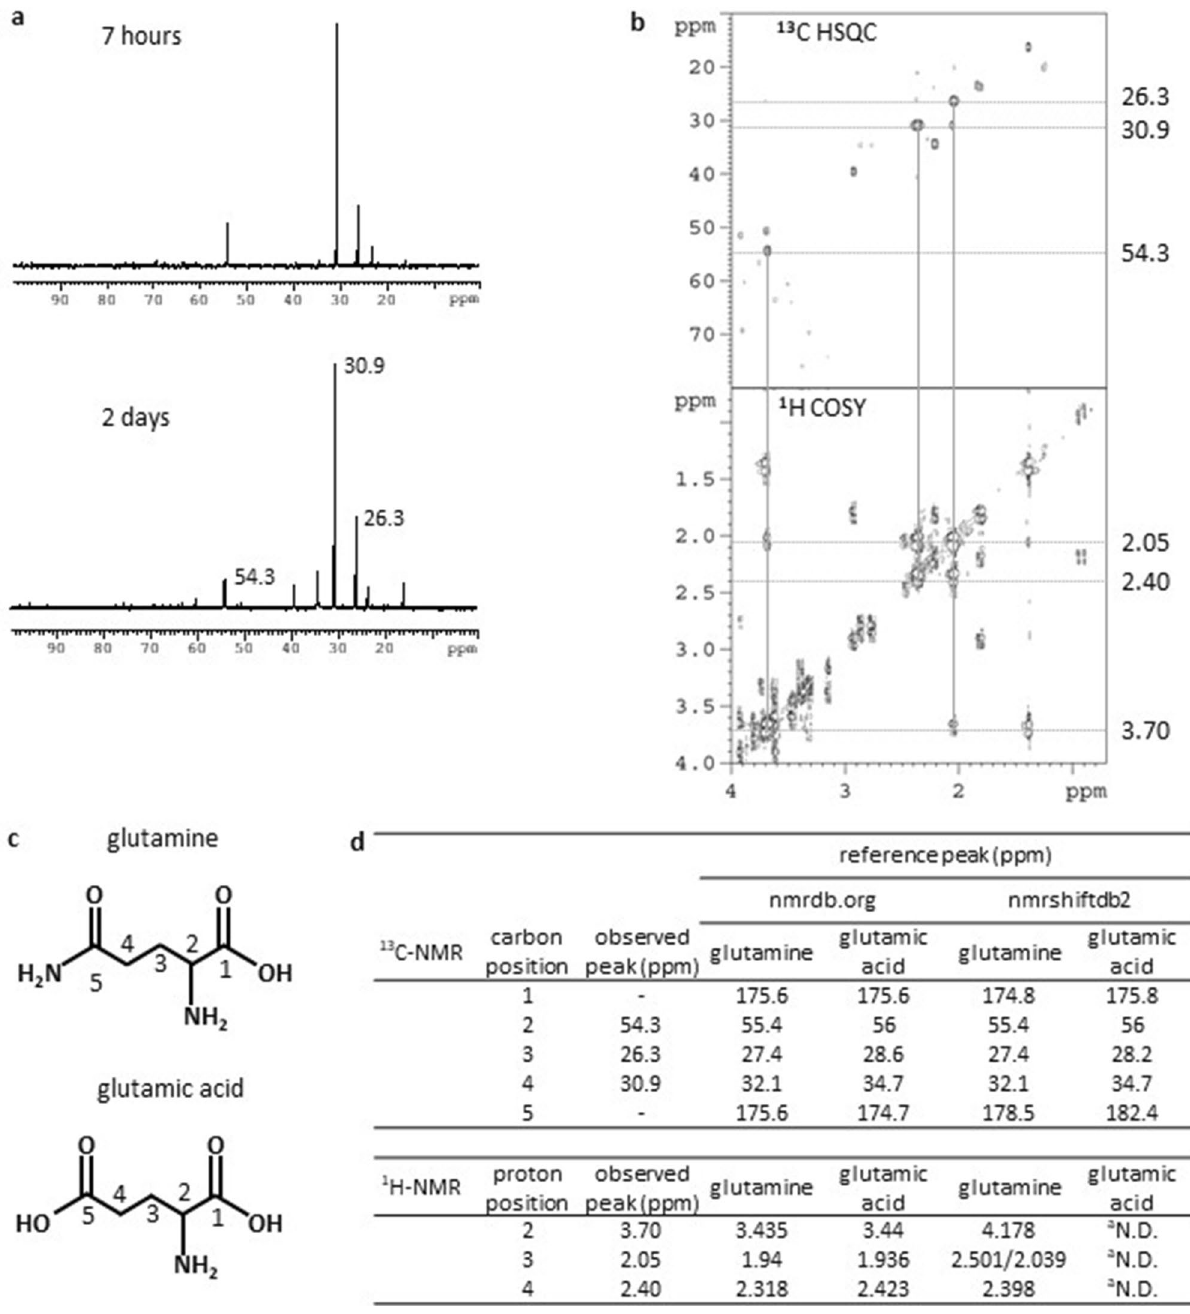
plants (Supplementary Table S2 online). Activation of genes involved in JA biosynthesis and its signaling was also observed in shoots of acetic-acid-treated plants, but again the profile was distinct from that of drought treat-